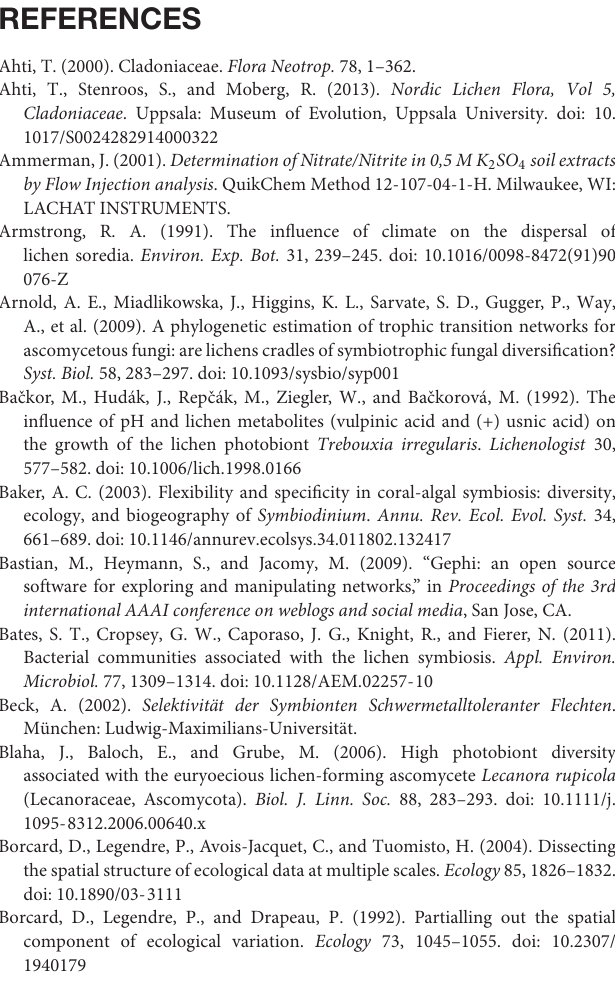
Supplementary Table 2 | List of all investigated 1,120 lichen samples, specifying their morphospecies determination, genetic affiliation to fungal and algal OTUs, clustering to the modules, recorded anatomical, morphological and chemical traits, and GenBank accession numbers. Supplementary Figure 1 | DNA species delimitation of fungi. The topology shown corresponds to the Bayesian ultrametric tree obtained in BEAST. The results of three species delimitation analyses (GMYC, bPTP, and ABGD) are shown along the tree, with the final OTU delimitation selected as a consensus between all delimitation approaches. Each color corresponded with the different fungal species delimited. Cladonia clades and subclades Stenroos et al. (2019). On the right, the total number of samples per each genotype is indicated by a barplot. The second vertical column represents which module from Figure 3 does each OTU get assigned to (displayed by colors: blue, Module 1; purple, Module 2; green, Module 3; orange, Module 4). Supplementary Figure 2 | DNA species delimitation of algae. The topology shown corresponds to the Bayesian ultrametric tree obtained in BEAST. The results of three species delimitation analyses (GMYC, bPTP, and ABGD) are shown along the tree, with the final OTU delimitation selected as a consensus between all delimitation approaches. Each color corresponded with the different algal species delimited. On the right, the total number of samples per each genotype is indicated by a barplot. The second vertical column represents which module from Figure 3 does each OTU get assigned to (displayed by colors: blue, Module 1; purple, Module 2; green, Module 3; orange, Module